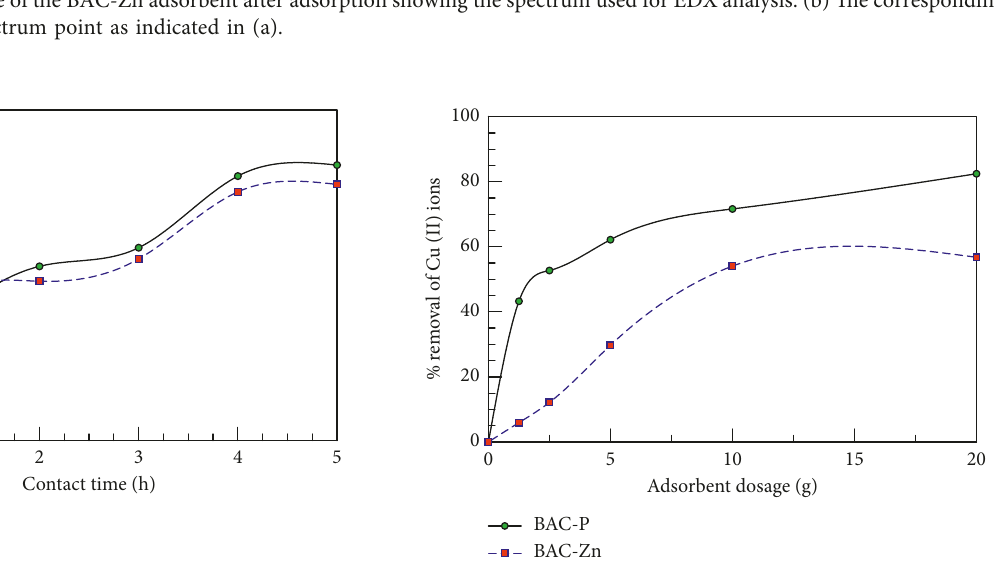
� 1g L − 1 , pH � 4.5, 0